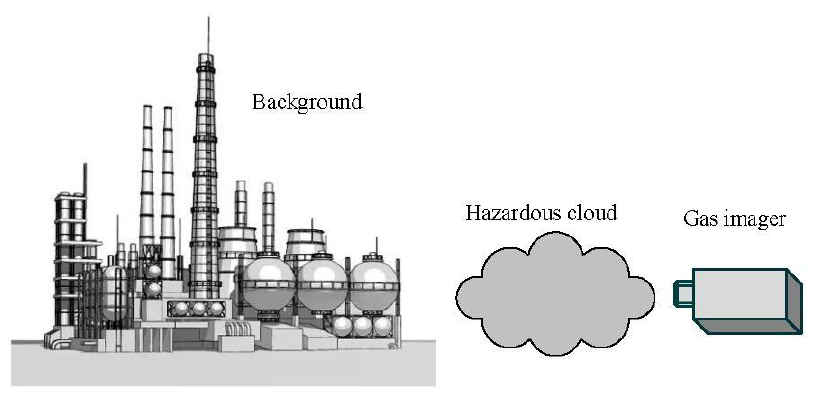
Figure 1. Gas remote sensing